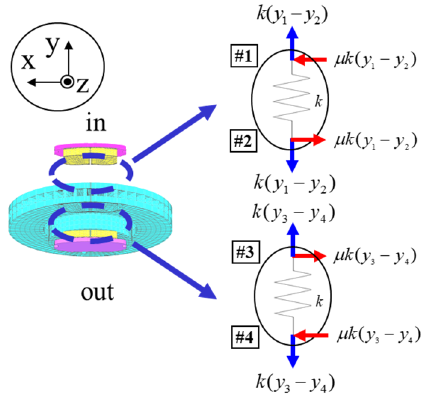
Figure 2. Contact condition between brake pad and disk.